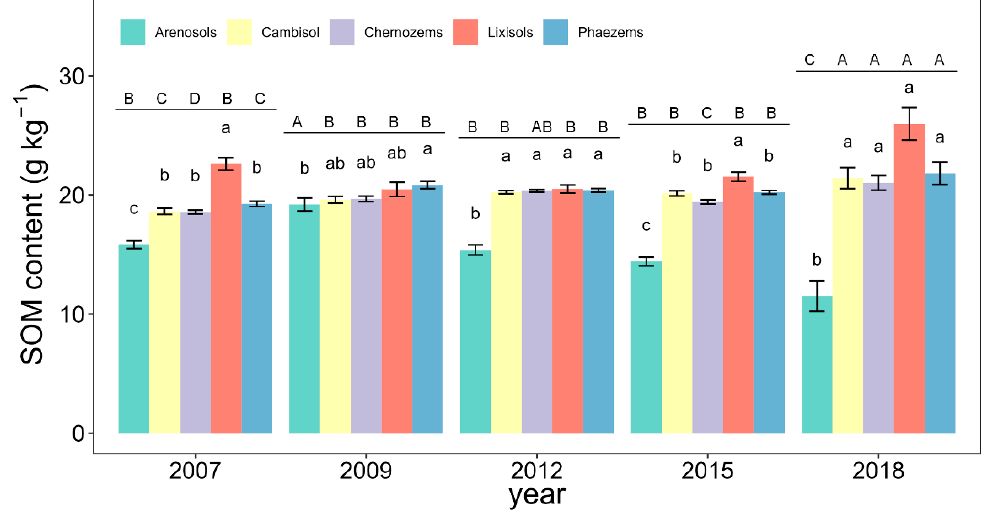
Figure 6. Soil organic matter (SOM) content for main soil types at different times. Notes: Different uppercase letters represent significant differences among years in the same soil type, and different lowercase letters represent significant differences among soil types in the same year, according to the least-significant difference (LSD) test at α = 0.05 level of probability.